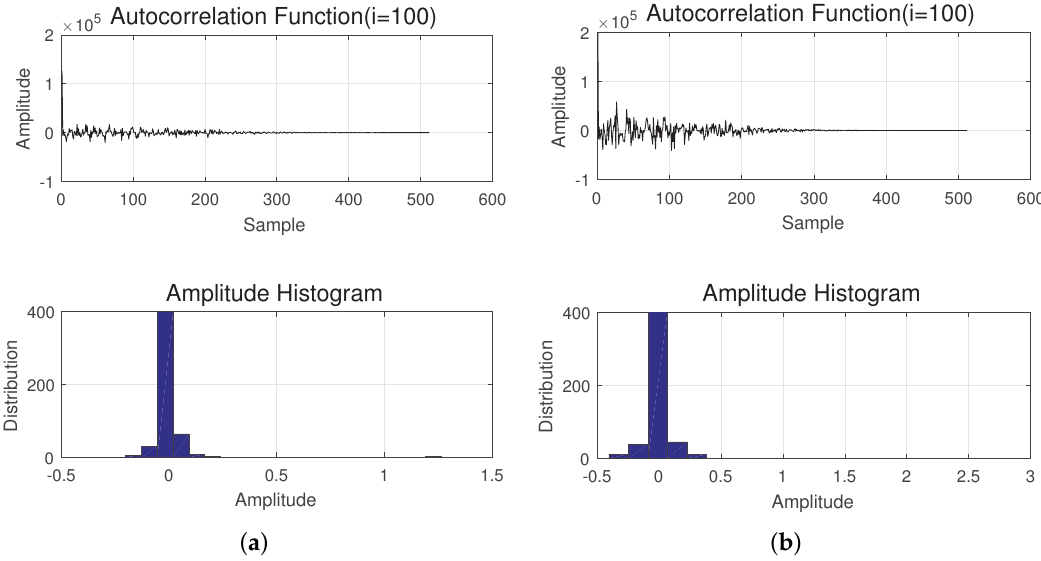
Figure 4. ( a ) Autocorrelation function of the sea clutter ( i = 100); ( b ) autocorrelation function of the land clutter ( i = 100).